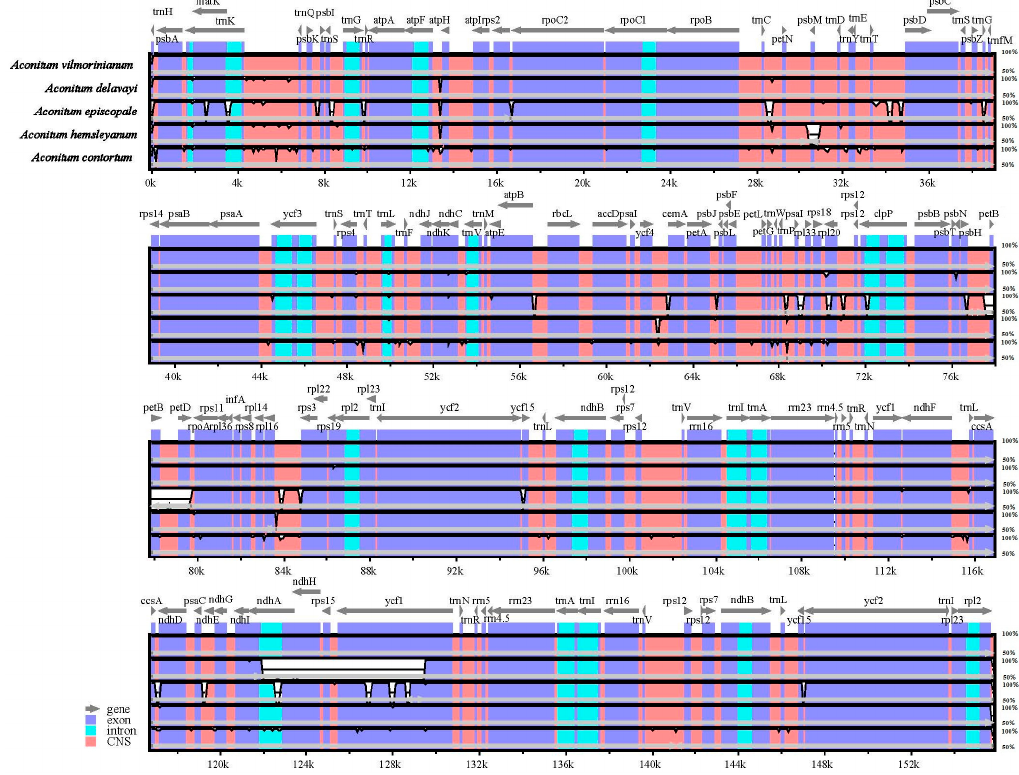
Figure 5. Comparison of five chloroplast genomes using A. vilmorinianum annotation as a reference. The vertical scale indicates the percentage of identity, ranging from 50 to 100%. The horizontal axis indicates the coordinates within the chloroplast genome. Genome regions are color-coded as exons, introns and conserved non-coding sequences (CNS).